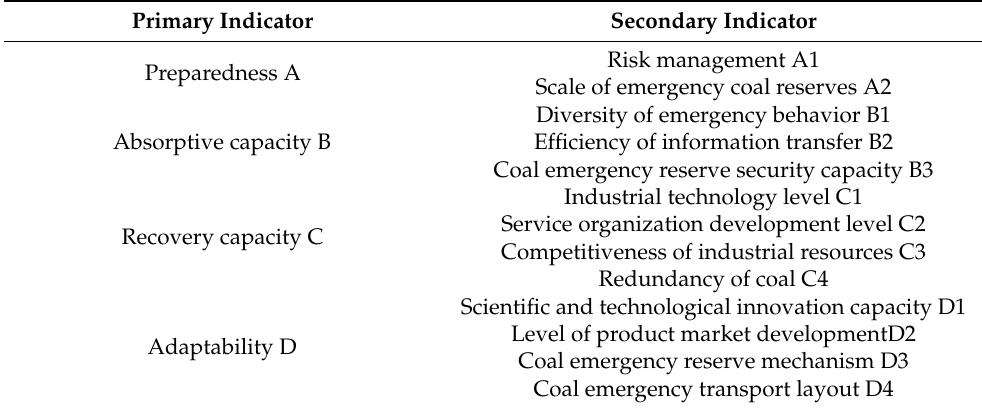
Table 1. Indicator system for evaluating the resilience of coal industrial chain and supply chain. Primary